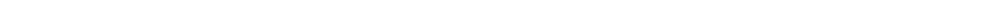
Fig. 1 Seasonal and pandemic in fl uenza A viruses induce endosomal ROS production via activation of NOX2 oxidase. a , b Confocal microscopy of wild-type (WT) mouse primary alveolar macrophages that were infected with in fl uenza A virus strain HKx31 (MOI of 10) for 1 h and labeled with antibody to the early endosome antigen 1 (EEA1) and antibodies to either a in fl uenza A virus nucleoprotein (NP) or b NOX2, and then with 4 ′ ,6 ′ -diamidino-2-phenylindole (DAPI; blue ). Also shown is the quanti fi cation of results ( n = 5). c , d Time-dependent elevation in endosomal ROS levels in mouse primary alveolar macrophages as assessed by OxyBURST (100 μ M) confocal fl uorescence microscropy and labeled with DAPI ( n = 5). e , f Endosomal ROS production in WT, NOX2 − /y and superoxide dismutase (SOD; 300 U/ml)-treated WT mouse primary alveolar macrophages as assessed by OxyBURST confocal fl uorescence microscopy in the absence or presence of HKx31 virus and labeled with DAPI ( n = 5). g Uninfected and HKx31 virus-infected mouse primary alveolar macrophages were labeled with OxyBURST and the acidi fi ed endosome marker Lysotracker (50 nM). Some cells were treated with ba fi lomycin A (Baf-A; 100 nM) to suppress acidi fi cation of endosomes ( n = 4). h Human alveolar macrophages infected with seasonal H3N2 (A/New York/55/2004, A/ Brisbane/9/2007), seasonal H1N1 (A/New Caledonia/20/1999, A/Solomon Islands/3/2006) and pandemic A(H1N1) pdm09 strains (A/California/7/ 2009, A/Auckland/1/2009) and labeled with OxyBURST for endosomal ROS ( n = 4). i , j Endosomal ROS production in WT mouse primary alveolar macrophages as assessed by OxyBURST fl uorescence microscopy exposed to either heat (56 º C)-inactivated HKx-31 virus (to block virus fusion) or UV- inactivated HKx-31 virus (to block replication) and labeled with DAPI ( n = 4). a – i Images are representative of > 150 cells analyzed over each